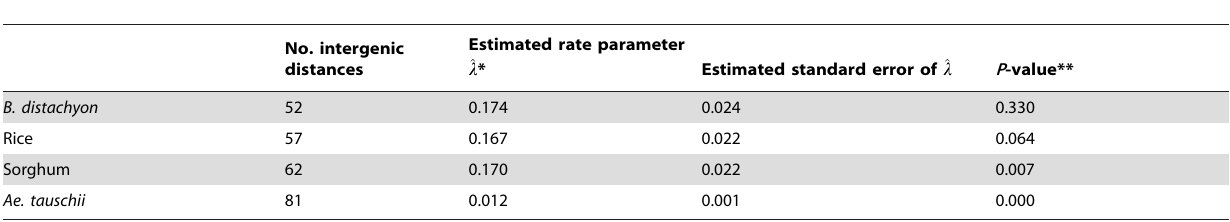
Table 1. Summary of test results for the null hypothesis that gene locations are uniformly distributed in the four species.